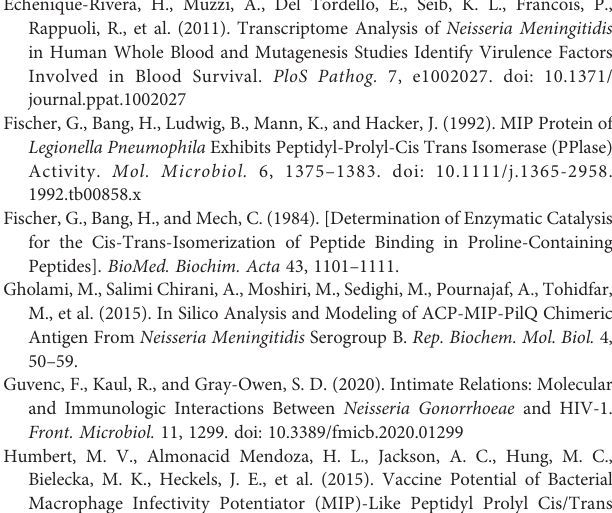
Supplementary Figure 1 | Dendrogram for the 32 non-redundant Ng-MIP alleles. Supplementary Figure 2 | Dendrogram for the 149 non-redundant Nm-MIP alleles. Supplementary Figure 3 | Comparison of the structures of MIP from pathogenic and commensal Neisseria spp. Each structure used built on the template 1fd9.1. of Legionella pneumophila using